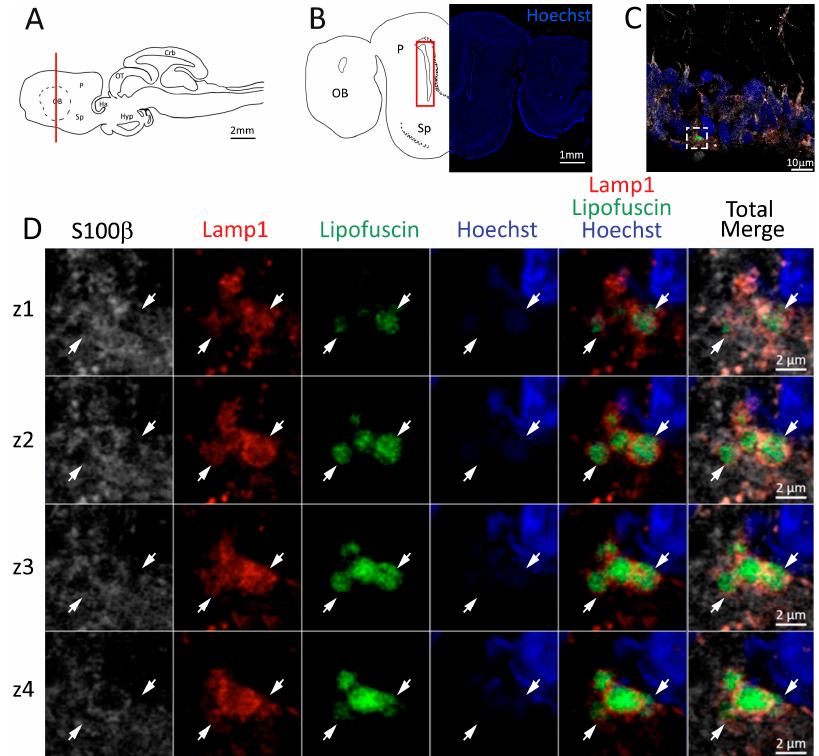
Figure 4. Presence of lipofuscin aggregates inside lysosomes in the anterior telencephalon of S. canicula . ( A ) Sagittal representation of S. canicula brain. The red line indicates the rostro-caudal localization of the section represented in the panel. ( B ) Coronal map of the anterior telencephalon. On the right, a real coronal section is stained with Hoechst 33342 to show nuclei distribution; on the left, a cartoon is drawn to indicate anatomical references. Red rectangle identifies the general area from which images are taken. ( C ) Area of the neurogenic niche where magnifications are taken from. ( D ) Lysosomes (Lamp1, red) containing lipofuscin (green) localized in radial glial cells (S100 β + , white) and are localized around the nucleus (Hoechst, blue). In the panel, four consecutive z planes are represented (z1–z4) to render the three-dimensionality of the inclusion. Each plane is acquired at1 μ m step in the z-axis from the previous. Last column represents the overlay of all four channels. White arrows indicate the localization of lysosomes containing lipofuscin. Abbreviations: OB: olfactory bulb, P: pallium, Sp: subpallium.